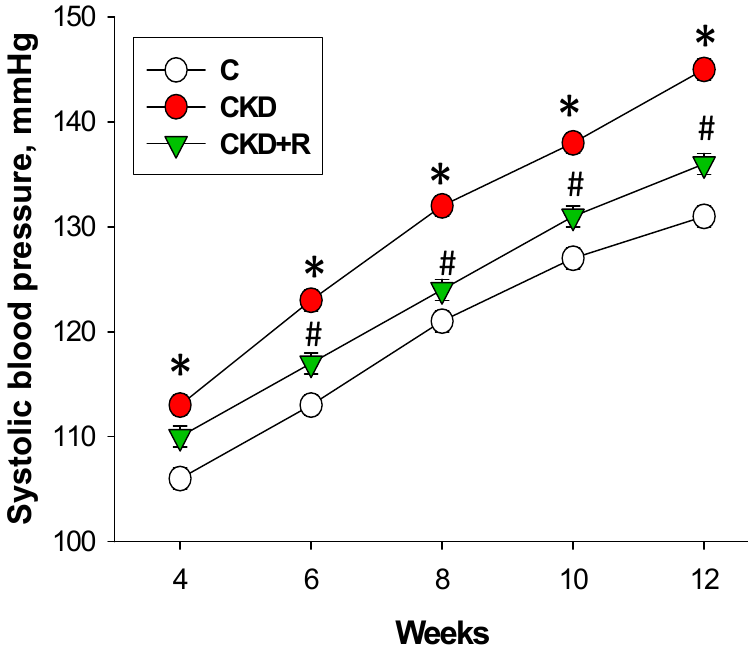
Figure 2. Effect of maternal CKD and R treatment on systolic blood pressure in 12-week-old male offspring. N = 7–8/group; * p < 0.05 vs. C; # p < 0.05 vs. CKD.